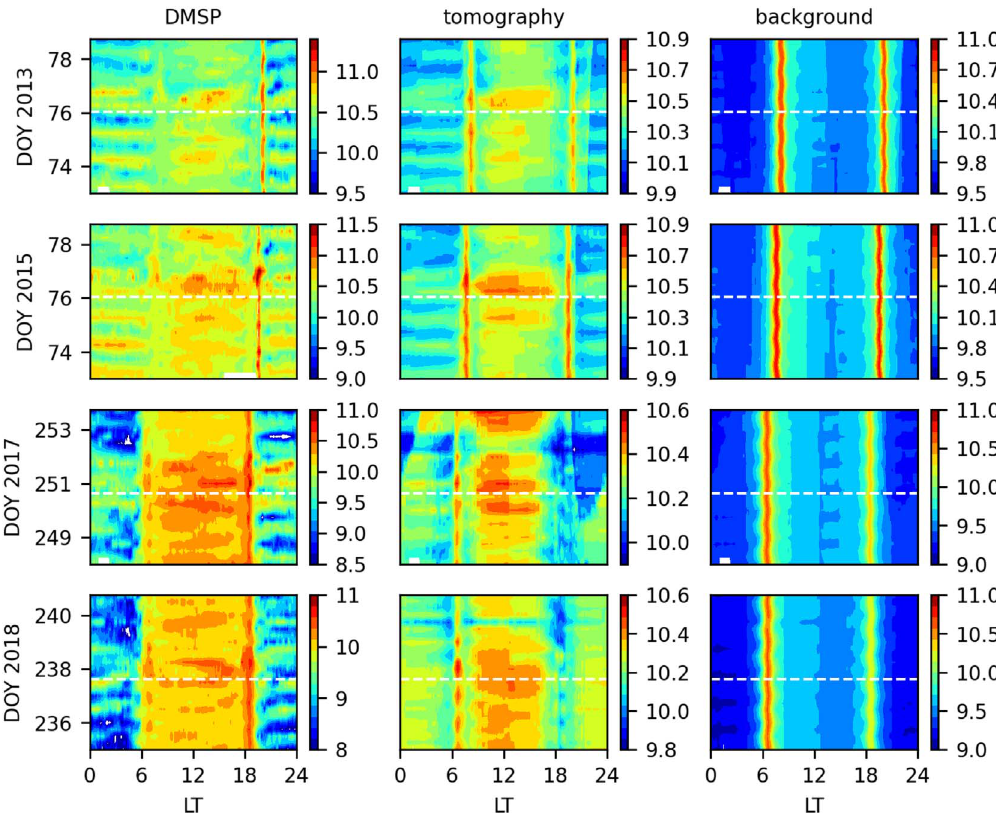
Fig. 9. Electron density distributions of DMSP, tomography and background in terms of local time and days of year. White line indicates the beginning of the corresponding storm. DMSP-18 was selected for years 2013 and 2015 and DMSP-17 was selected for years 2017 and 2018. Color scale varies within each plot to adapt to a better visualization of the spatial distributions. Units of color bar are in log( Ne ) with base